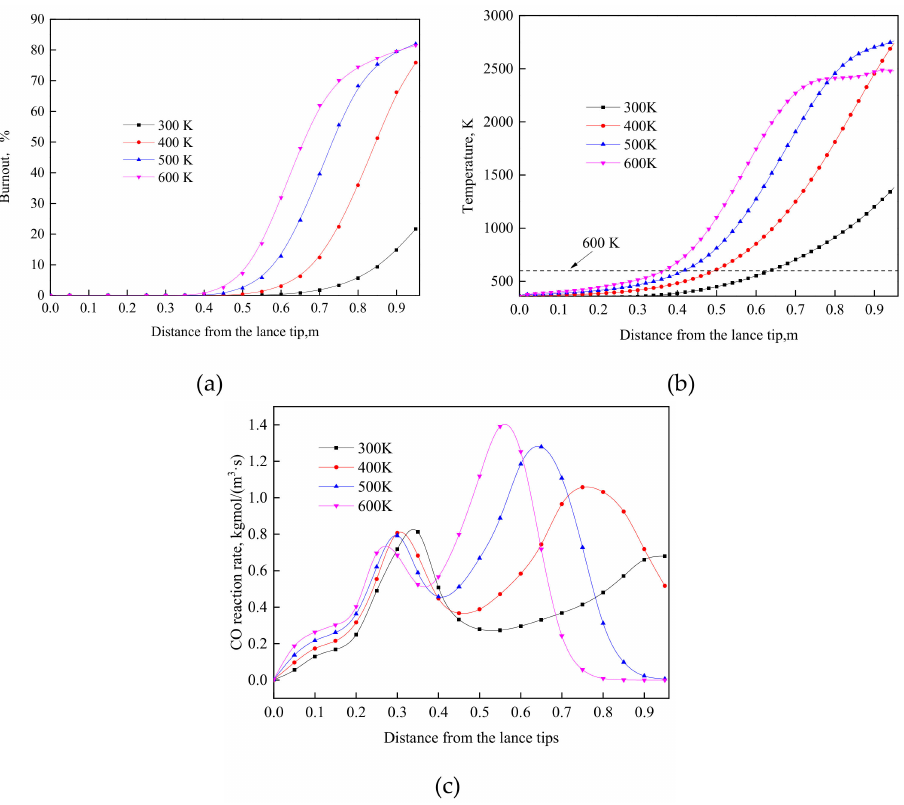
Figure 4. E ff ect of oxygen temperature: ( a ) coal burnout at di ff erent positions; ( b ) coal particle temperature at di ff erent positions; ( c ) CO reaction